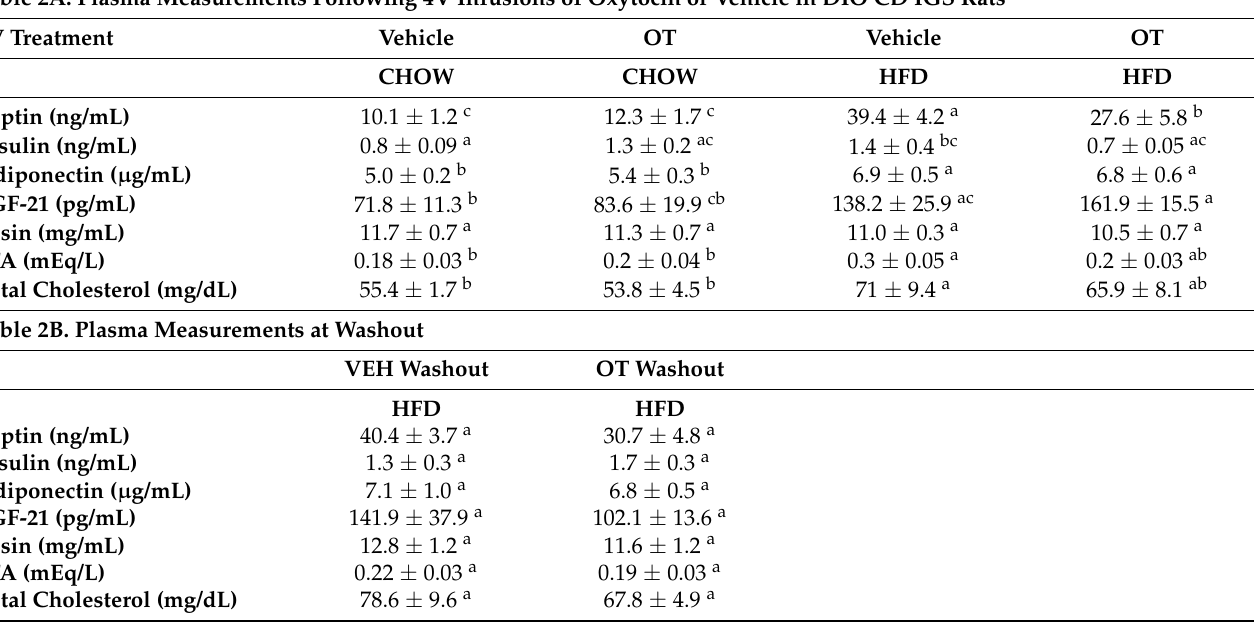
Table 2. Plasma measurements following (A) chronic 4V infusions of OT or vehicle or (B) washout period in male DIO CD IGS rats. Table 2A. Plasma Measurements Following 4V Infusions of Oxytocin or Vehicle in DIO CD IGS Rats